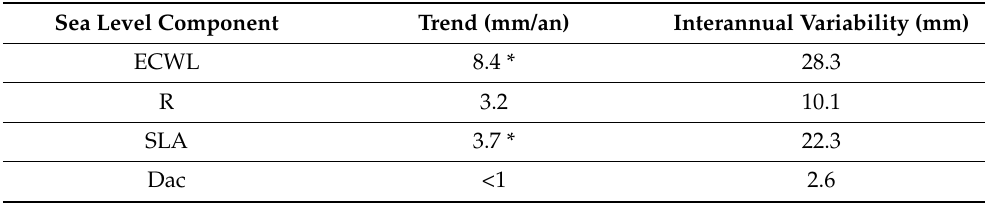
Table 1. Relative trends of different model parameters in the increase in extreme water levels in Dakar, from 1994 to 2015 and their interannual variations. * indicates trends statistically significant, passing the NULL hypothesis using the Mann – Kendall test, at a 95% level.